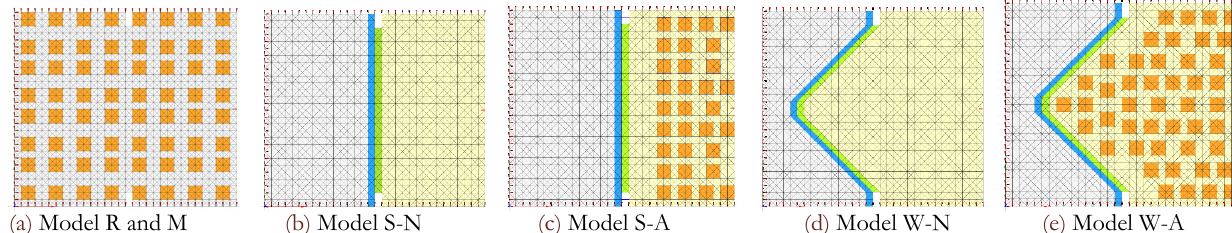
Figure 4: FEM models with a dimension of 5.6 x 6.4 mm which consists of triangle elements sized 0.2 mm (bottom) and 0.1 mm (height). At the top and bottom they have notches of 0.4 mm depth. The aggregate is sized in 0.4 x 0.4 mm.